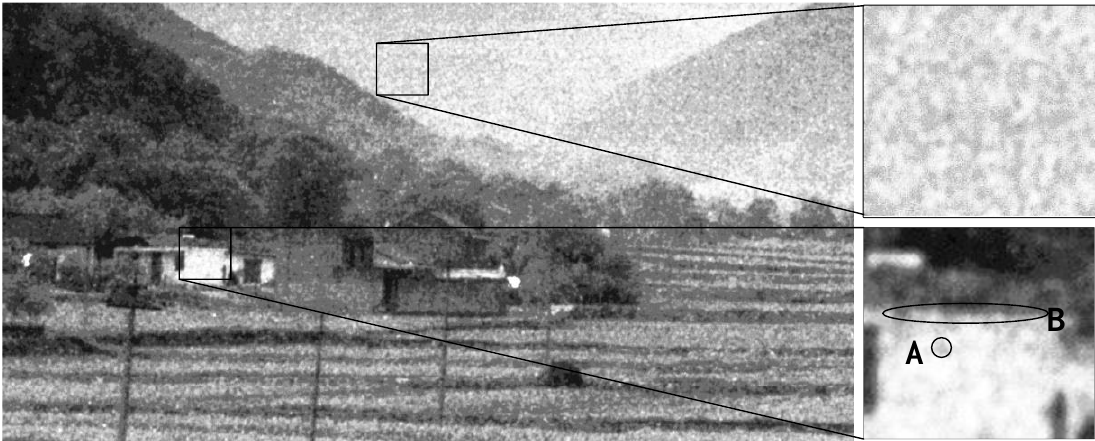
Figure 1. An image captured by an ICCD sensor and its noise pattern (enhanced by histogram equalization).